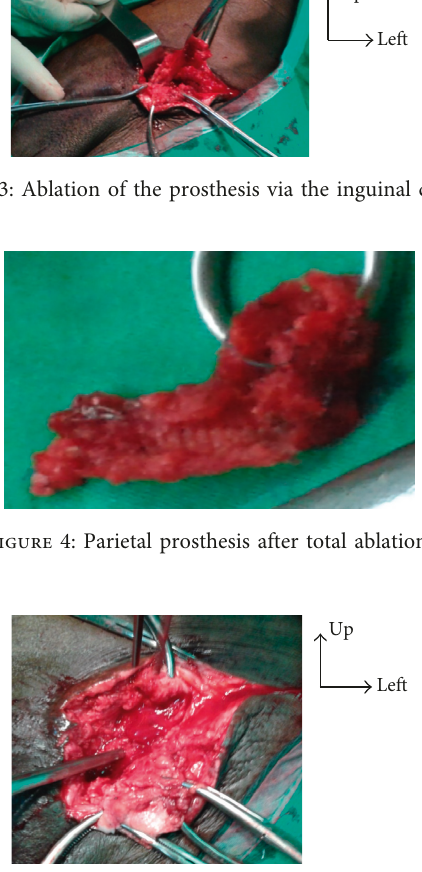
Figure 5: Ileal lumen after total ablation of the prosthesis.